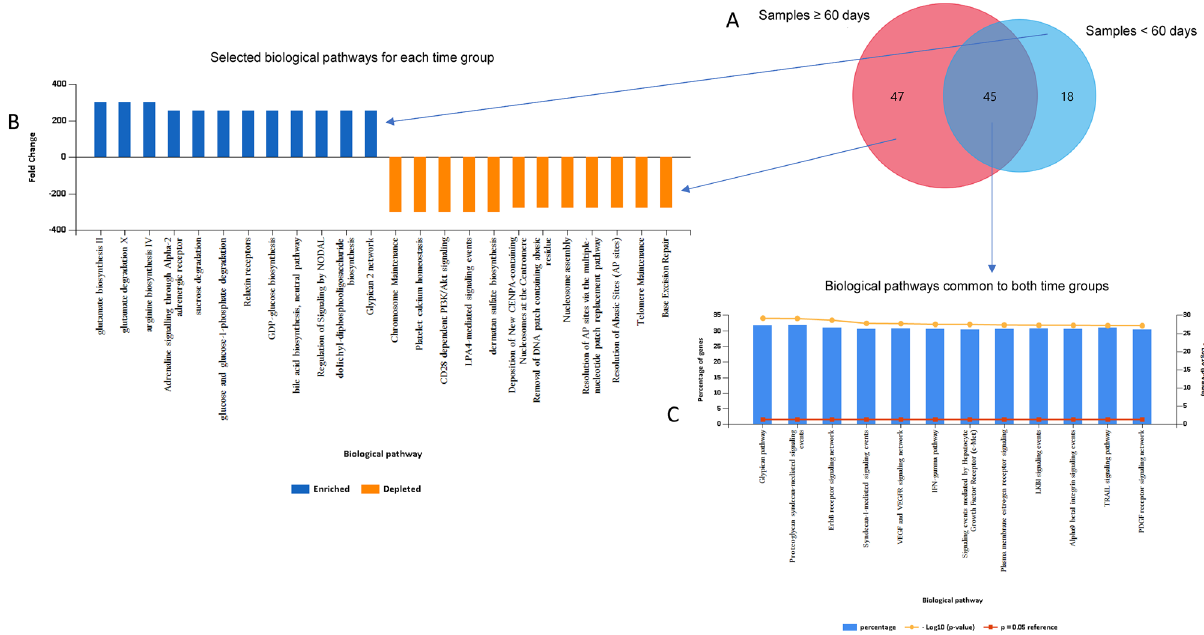
Figure 7. Significant miRNAs (adjusted p-value ≤ 0.05) between control samples vs. samples < 60 days and control samples vs samples ≥ 60 days were tested for FunRich pathway enrichment analysis. Results were compared by ( A ) Venn overlaps showing the number of miRNA in each category ( B ) exclusive pathways for ≥ 60 days and < 60 days and ( C ) pathways common to both time